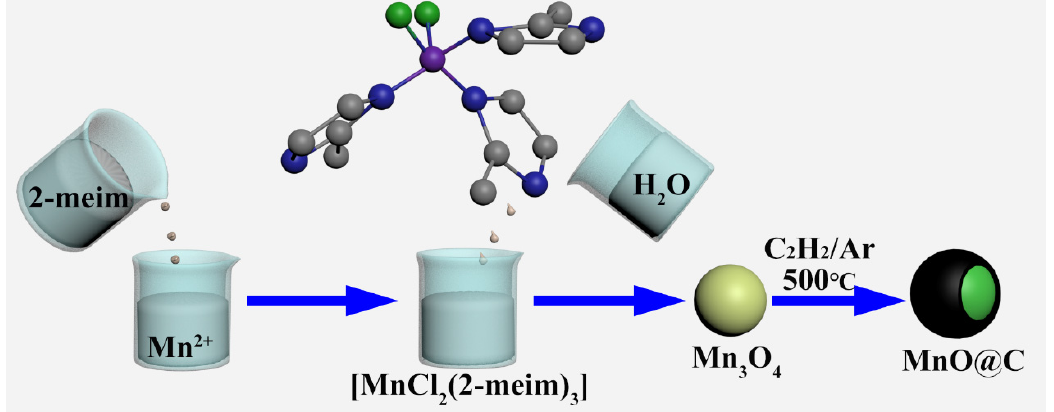
Figure 1. Schematic illustration for the preparation of MnO@C nanocomposite.